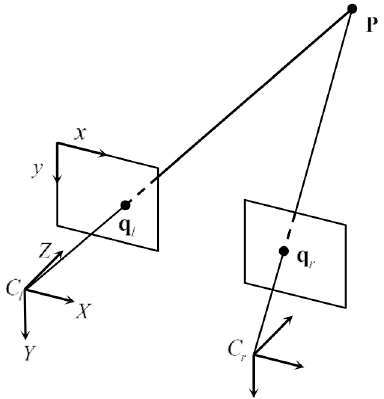
Figure 2. Stereo observation